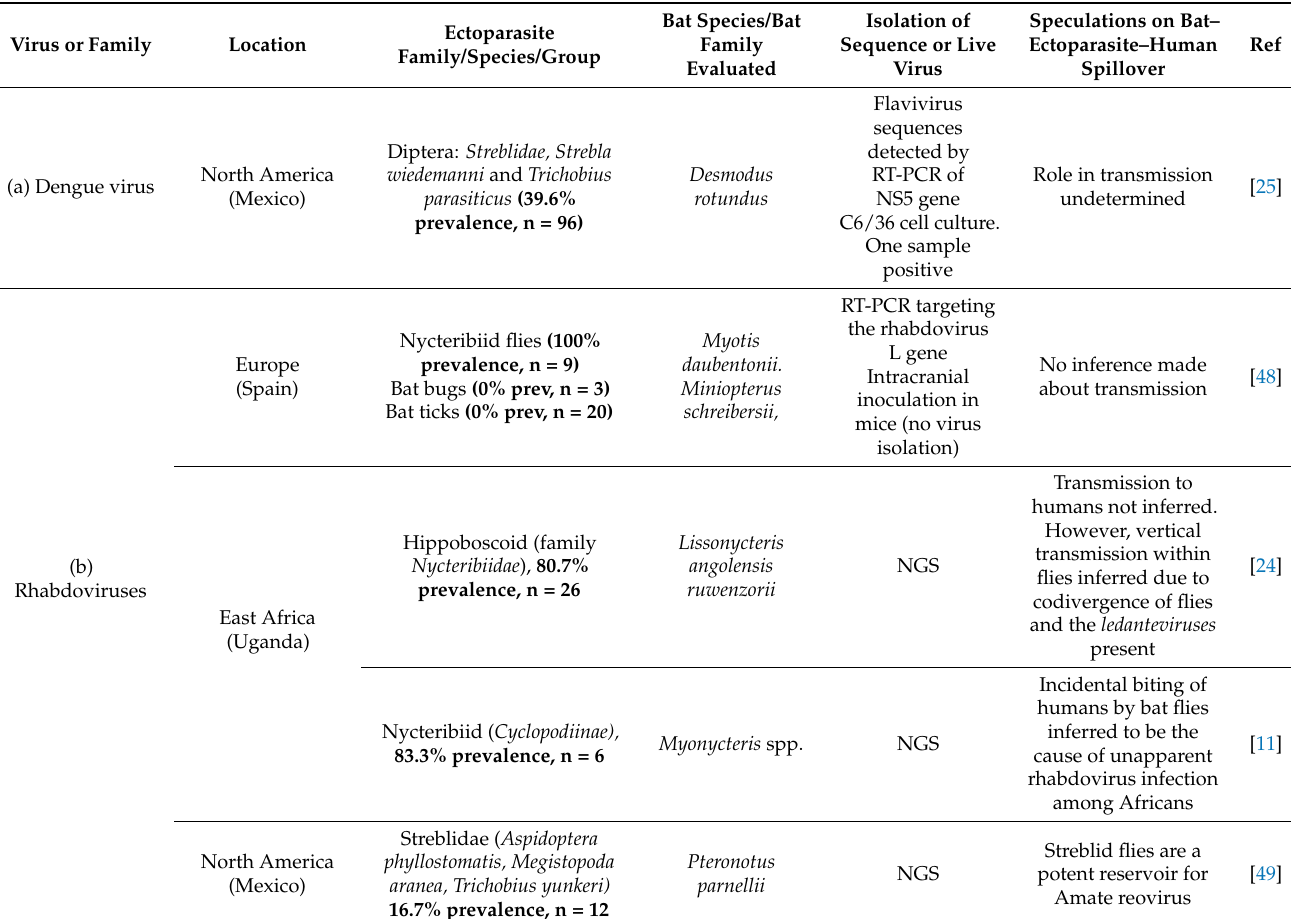
Table 2. A worldwide summary of studies on bat ectoparasite